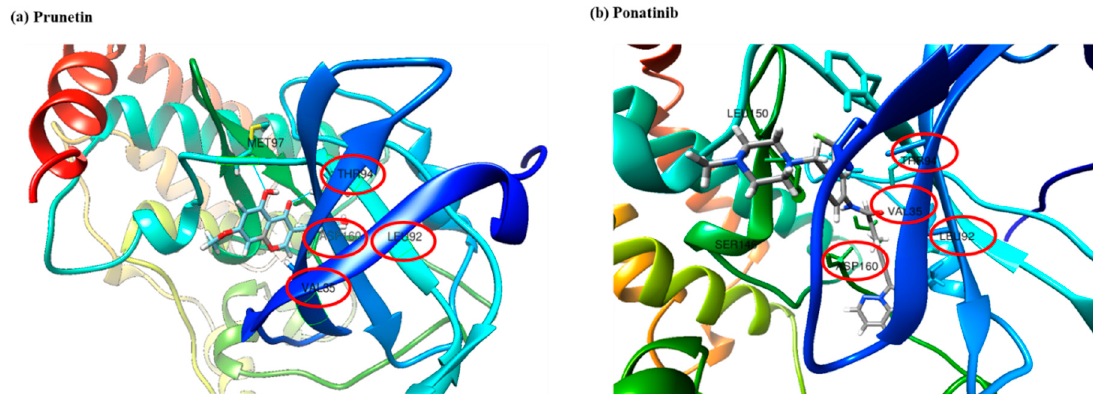
Figure 7. In silico molecular docking analysis of the ligands prunetin and ponatinib at the same binding pockets of the target. ( a ) The 3D structure of RIPK3 bound efficiently with compound prunetin with its interacting amino acids MET97, THR94, LEU92, VAL35, and ASP160. ( b ) The 3D structure of RIPK3 bound efficiently with the known inhibitor compound ponatinib with its interacting amino acids LEU150, ASP160, VAL35, SER146, THR94, and LEU92. The common amino acid residues involved in the interaction are circled in red color.